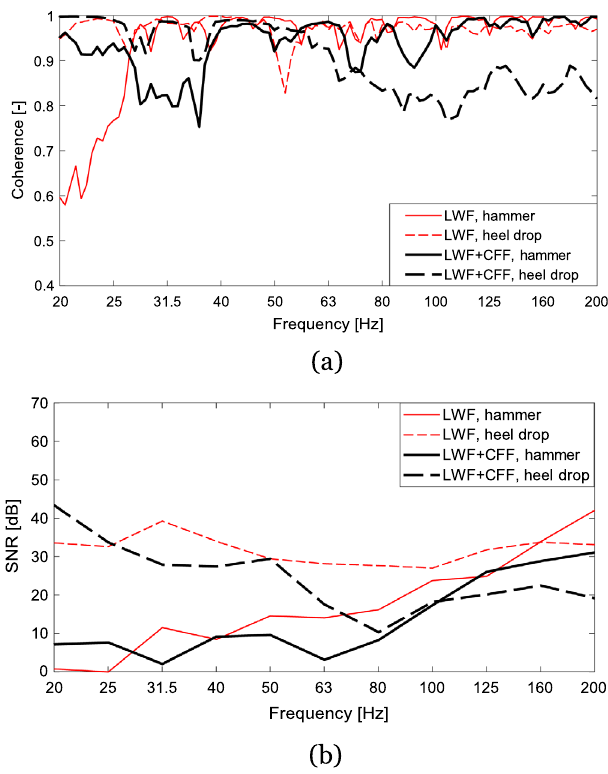
Figure 18. Coherence and signal-to-noise ratio of the measure- ments. (a) Coherence of the fl oor mobility measurements. (b) Signal-to-noise ratio of the impact sound measurements in the receiving room.